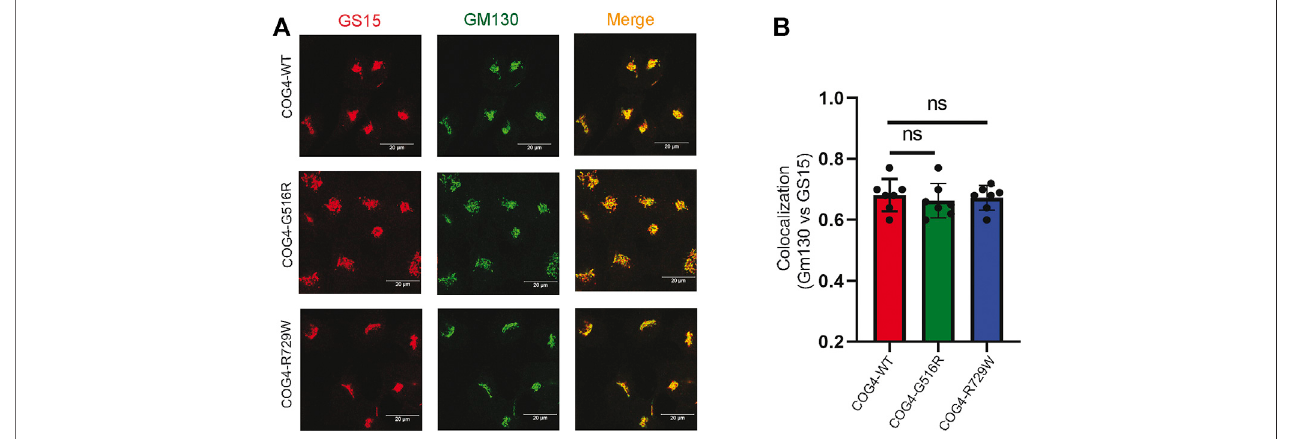
FIGURE5| ExpressionofG516RandR729Wmutantsdonotaffectthelocalizationofv-SNAREGS15. (A) RPE1rescuedCOG4-WT-3myc,COG4-G516R-3myc, and COG4-R729-3myc cells were stained with GM130 (green) and GS15 (red). Scale bar 20um. (B) Colocalization of GS15 with GM130 has been analyzed using Pearson ’ s correlation coef fi cient. Quanti fi cation of colocalization in 20 cells analyzed. Statistical signi fi cance was calculated by GraphPad Prism 8 using one-way ANOVA. p > 0.05, nonsigni fi cant (ns). Error bar represents mean ±